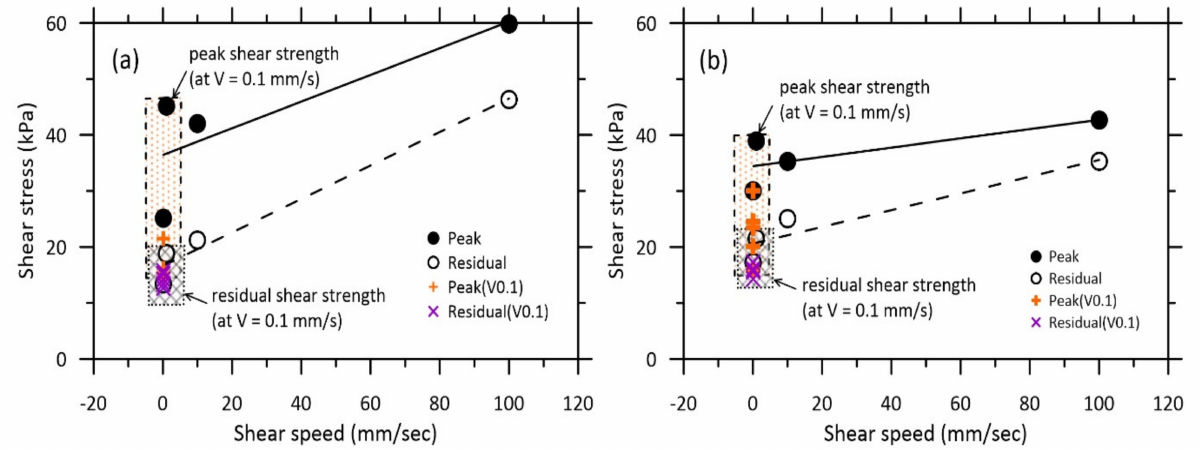
Figure 8. Shear stress as a function of shearing speed: ( a ) drained and ( b ) undrained